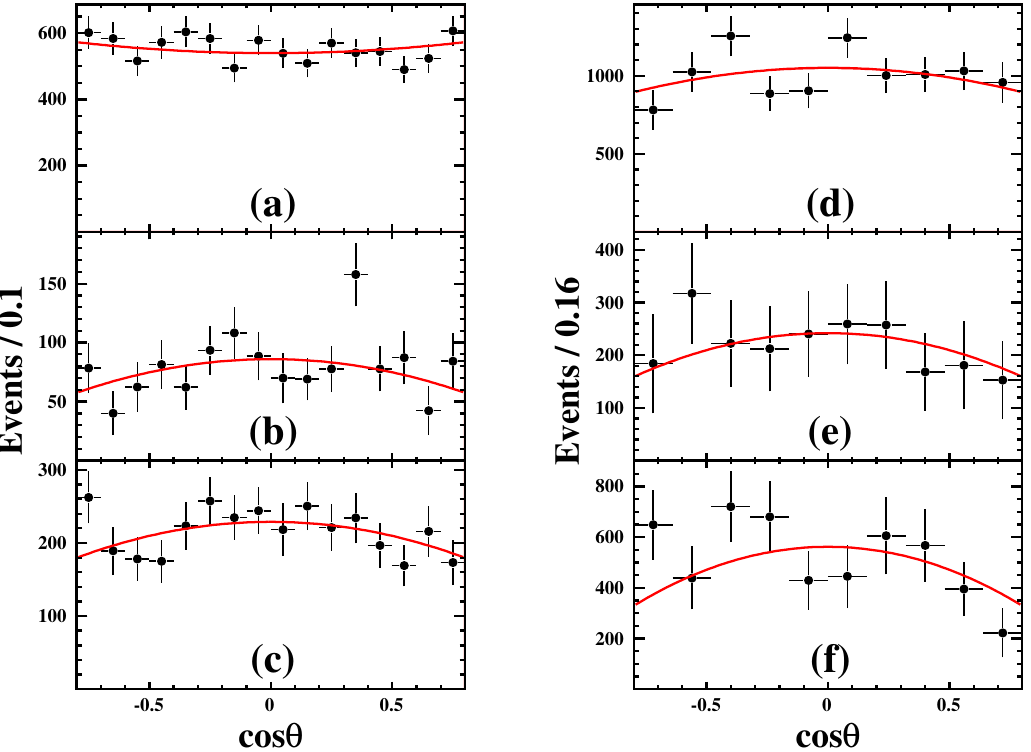
Figure 3 . Angular distributions for χ cJ → Ξ − ¯Ξ + processes with (a) J = 0 , (b) J = 1 , (c) J = 2 and χ cJ → Ξ 0 ¯Ξ 0 processes with (d) J = 0 , (e) J = 1 , (f) J = 2 . Dots with error bars are efficiency- corrected data and the solid lines show the fit results.